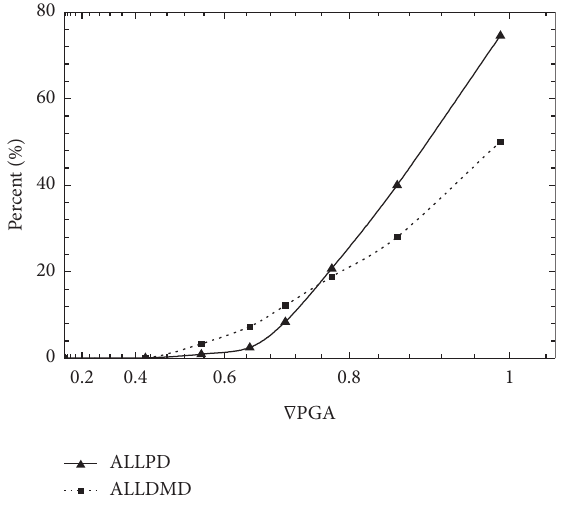
Figure 16: Dissipated energy growth